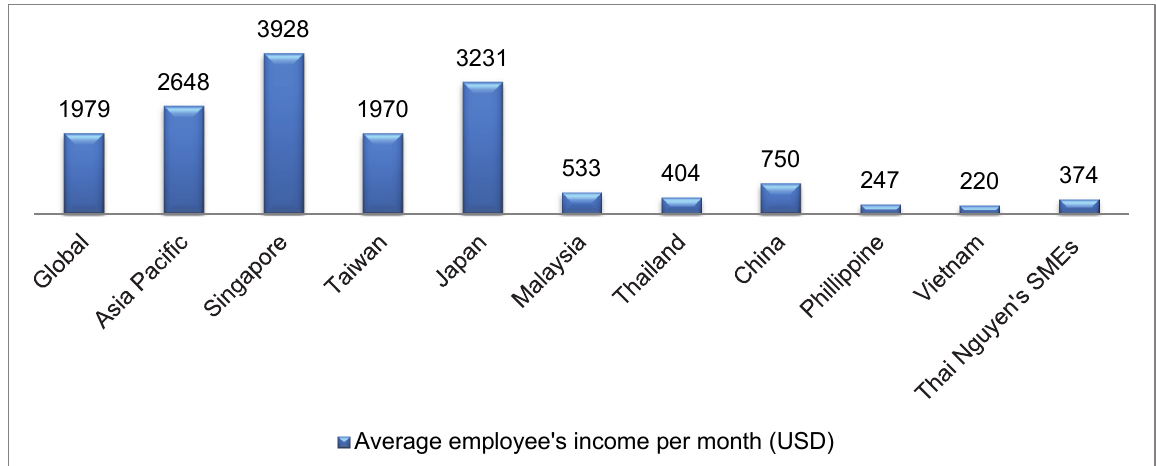
Fig. 1. Average employee’s income per month in Vietnam and some Asia Pacific countries Source : Manpower Group Solutions